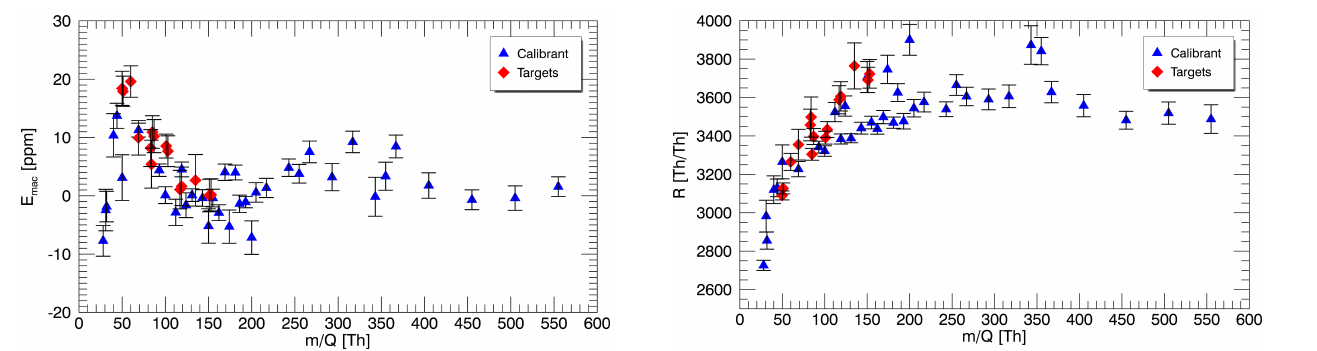
Figure 1. Mass accuracy ( E mac ) in ppm over the whole mass range as determined for calibrant masses and masses of target substances during a measurement series. Error bars: 1-fold standard deviation from 44 individual measurements. Mean mass resolving power used in this measurement series: R = 3500.